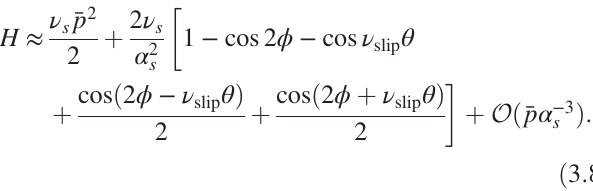
depicted in Fig. 1. For